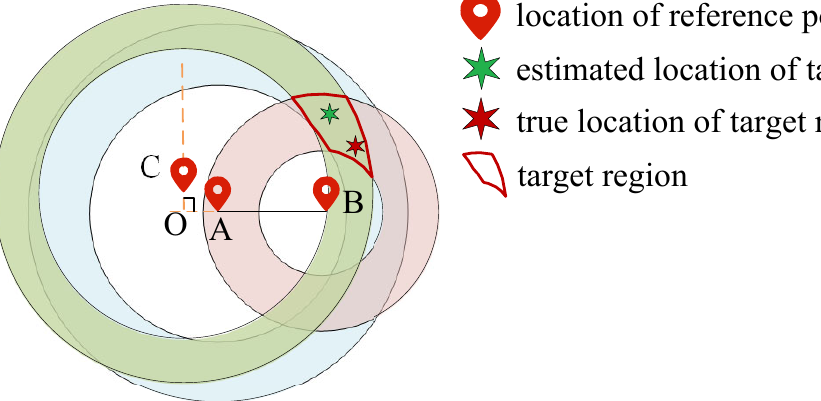
Figure 11. Locating target node.